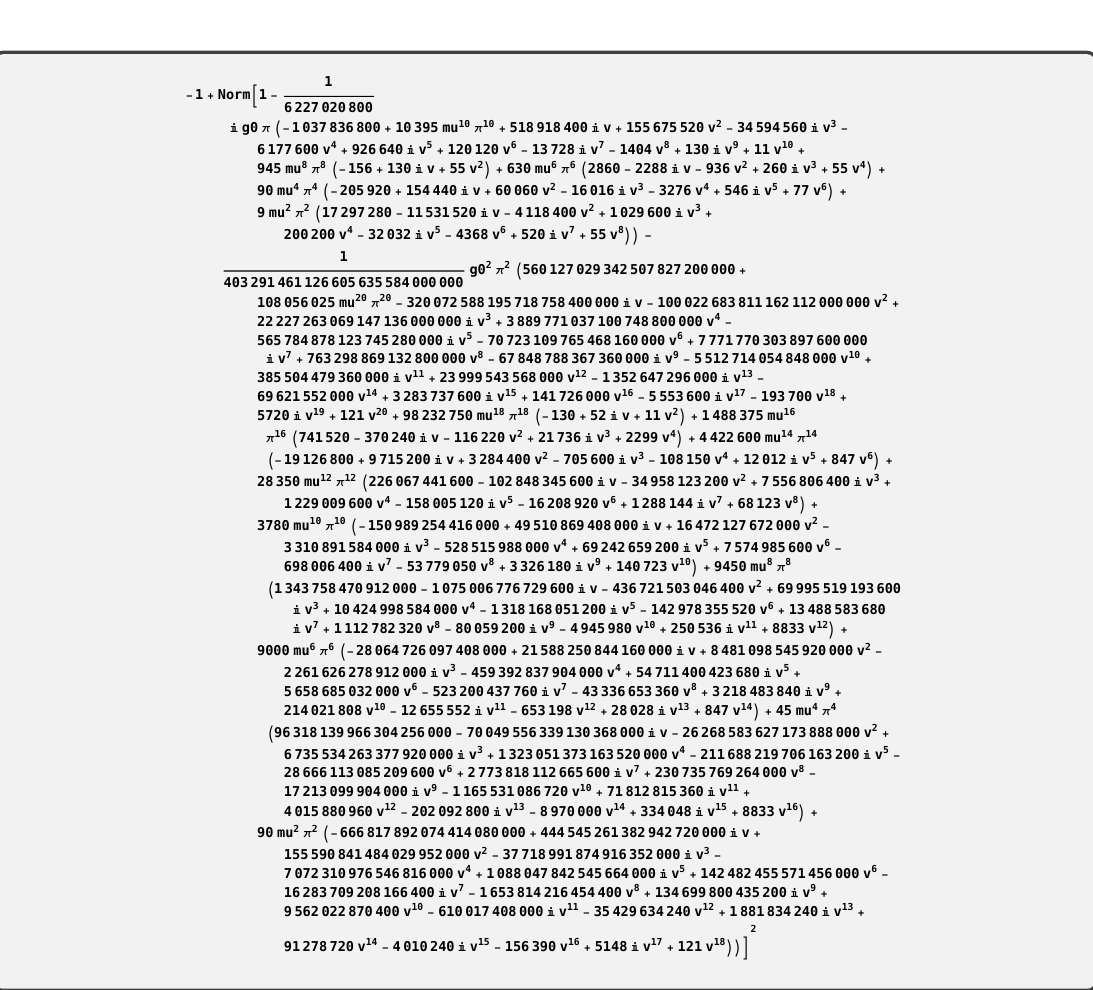
Figure A2. Mathematica code for Hermite